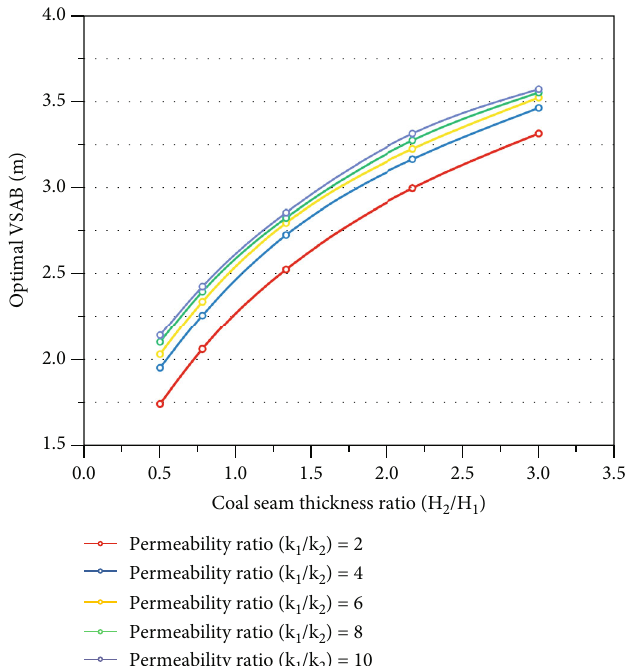
/ H ff erent coal seam permeability ratios ( k 2 1 ) for di